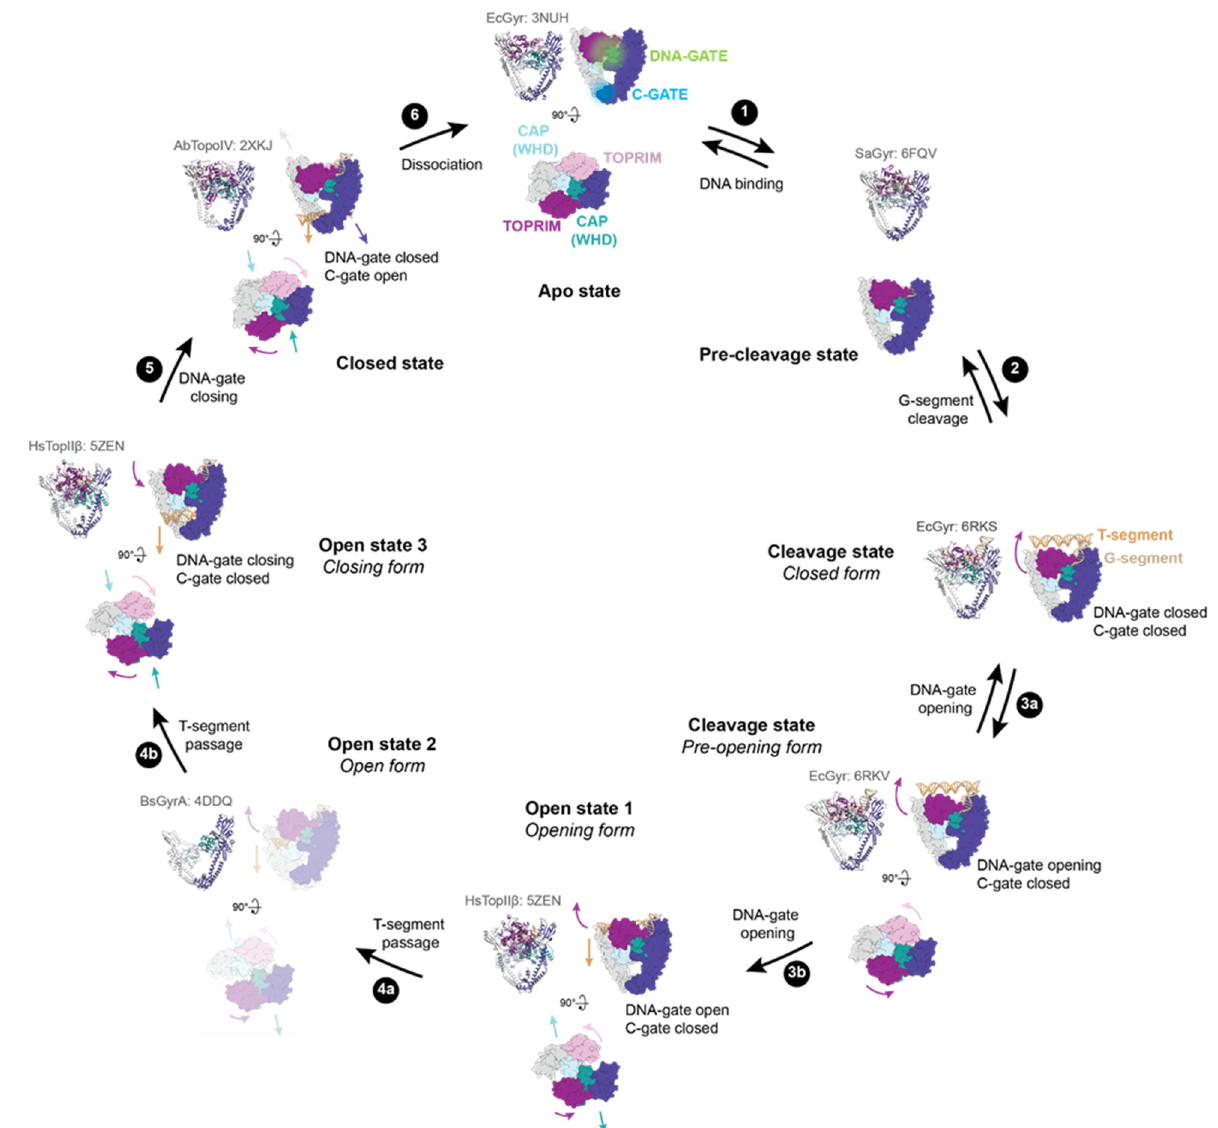
Figure 2. DNA-gate opening mechanism of type IIA enzymes. All the shown intermediates were structurally determined by X-ray crystallography or cryo-electron microscopy (cryo-EM). PDB ac- cession codes are indicated in light grey. Structure representations restricted to the DNA-bind- ing/cleavage domain were generated from the E. coli DNA gyrase structure without DNA and the insertion domain for clarity. TOPRIM domains are coloured dark magenta and plum. CAP (WHD) domains are coloured light blue and dark cyan. The other domains are coloured in dark slate blue and grey. The G-segment is shown in tan, and the T-segment (modelled) is in sandy brown. (1) G- segment binds to the DNA binding-groove formed by the TOPRIM-CAP(WHD)-Tower domains. (2) DNA binding triggers a rotation of the TOPRIM domains, resulting in a repositioning of the acidic motif with metal ions close to the catalytic tyrosine residues (CAP/WHD) and cleavage of the G-segment. (3) DNA-gate opening involving sliding and swivelling motions (TOPRIM/WHD (CAP)) of the two halves of the protein against each other. 3a and 3b show the transition to the closed form to the pre-opening form of the DNA-gate. The dimer remains together thanks to inter- actions in the C-gate. (4) From these movements, a funnel-shaped channel is revealed between the two halves of the DNA-gate allowing T-segment passage to change DNA topology. 4a shows the T- segment passage through the upper part of the DNA-gate. The structure of GyrA in an opened conformation suggests that a wider opening of the DNA gate happens to complete strand passage as illustrated in step 4b. (5) After the T-segment passage through cleaved G-segment, the DNA-gate is closed and the G-segment is re-ligated. Once the DNA-gate is closed, the C-gate opens to release